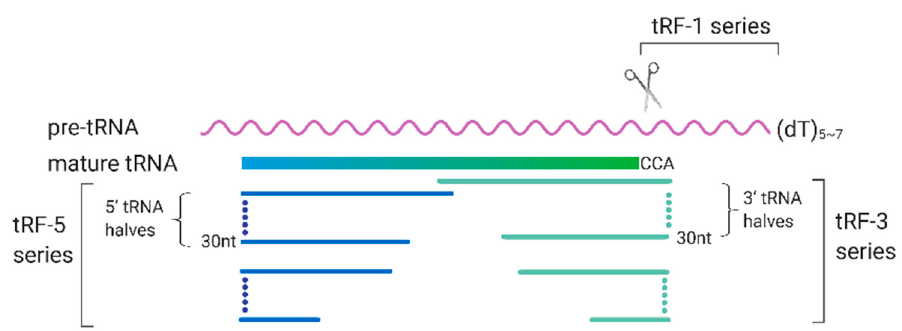
Figure 3. Biogenesis and classification of transfer RNA (tRNA)-derived RNA fragments (tRFs). The